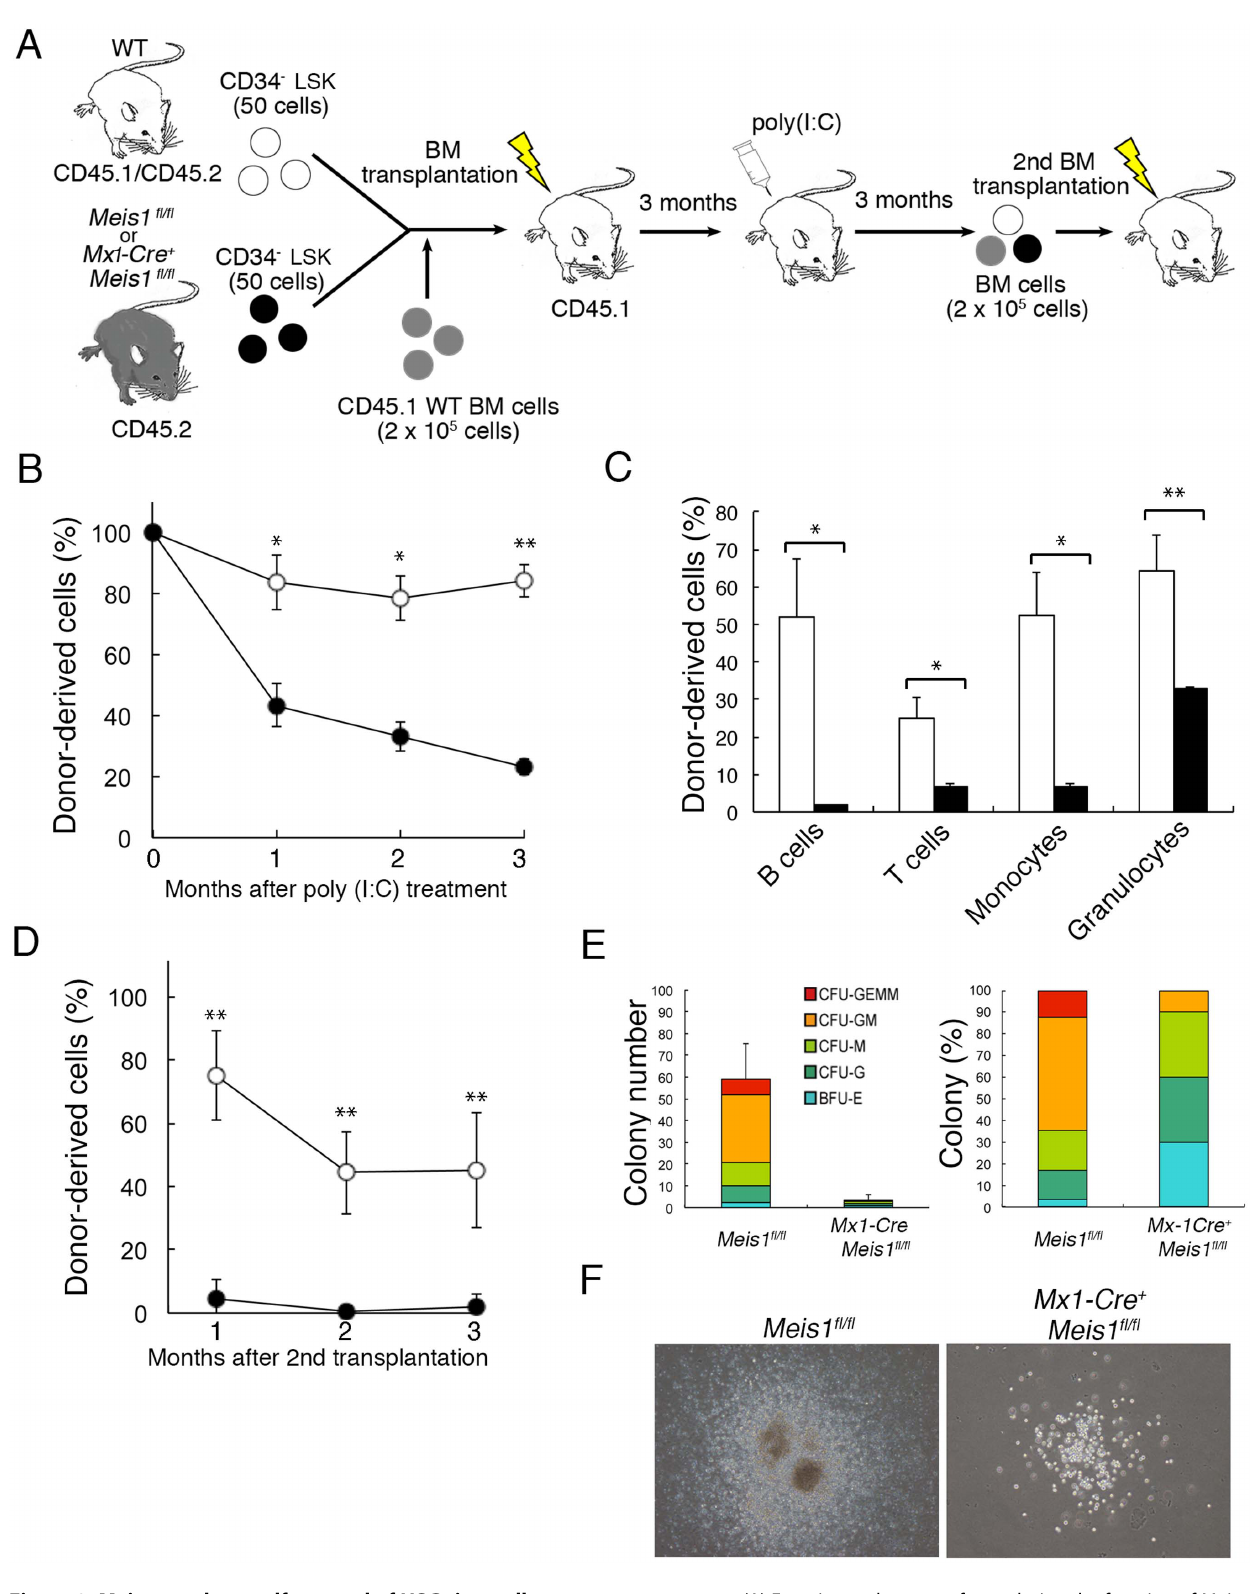
Figure 3. Meis1 regulates self-renewal of HSCs in a cell autonomous manner. (A) Experimental strategy for analyzing the function of Meis1 in HSCs. Mice with chimeric BM were generated by transplanting CD34 2 LSK cells (50 cells/mouse) from Mx1-Cre + Meis1 fl/fl or control Meis1 fl/fl mice (CD45.2) and an equal number of CD34 2 LSK cells from wild-type mice (CD45.1/CD45.2) with CD45.1 BM supports cells in lethally irradiated CD45.1 recipient mice. A subset of mice was treated with poly(I:C) three months after transplantation. (B) Mean percentages of CD45.2 + cells 6 SD in the peripheral blood derived from Meis1 fl/fl (n=6; open circles) and Mx1-Cre + Meis1 fl/fl (n=6; closed circles) CD34 2 LSK cells after poly(I:C) treatment. Initial